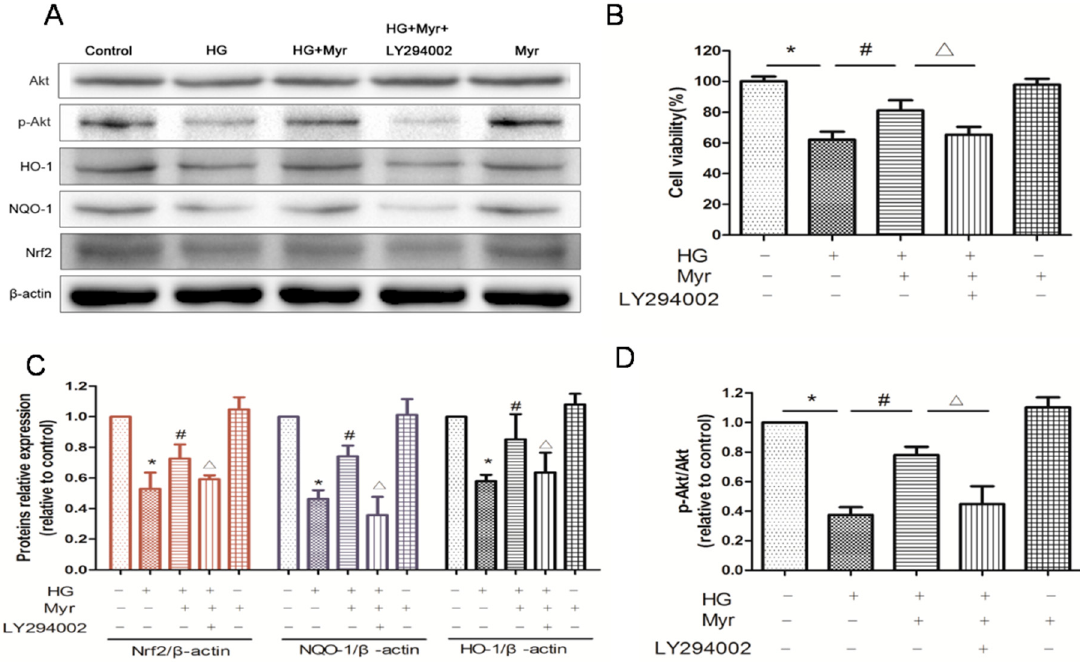
Figure 5. Myricitrin exerts its effects by activating the PI3K/Akt pathway and Nrf2/ARE signaling. ( A ) Representative immunoblots of the protein expression of phospho- and total Akt, HO-1, NQO-1 and Nrf2; ( B ) Cell viability in H9c2 cells with 4 h pretreatment of the PI3K inhibitor LY294002 (50 μ M) was evaluated by MTT assay. n = 10 wells per group. Quantitative analysis of Nrf2, NQO-1 and HO-1 expression levels ( C ) and the statistical analysis of the p-Akt/Akt expression level relative to the control group ( D ). Values are represented as the mean ± SD ( n = 3). * p < 0.01 vs. control; # p < 0.01 vs. HG; △ p < 0.05 vs. HG + Myr. + represents treated; − represents untreated.